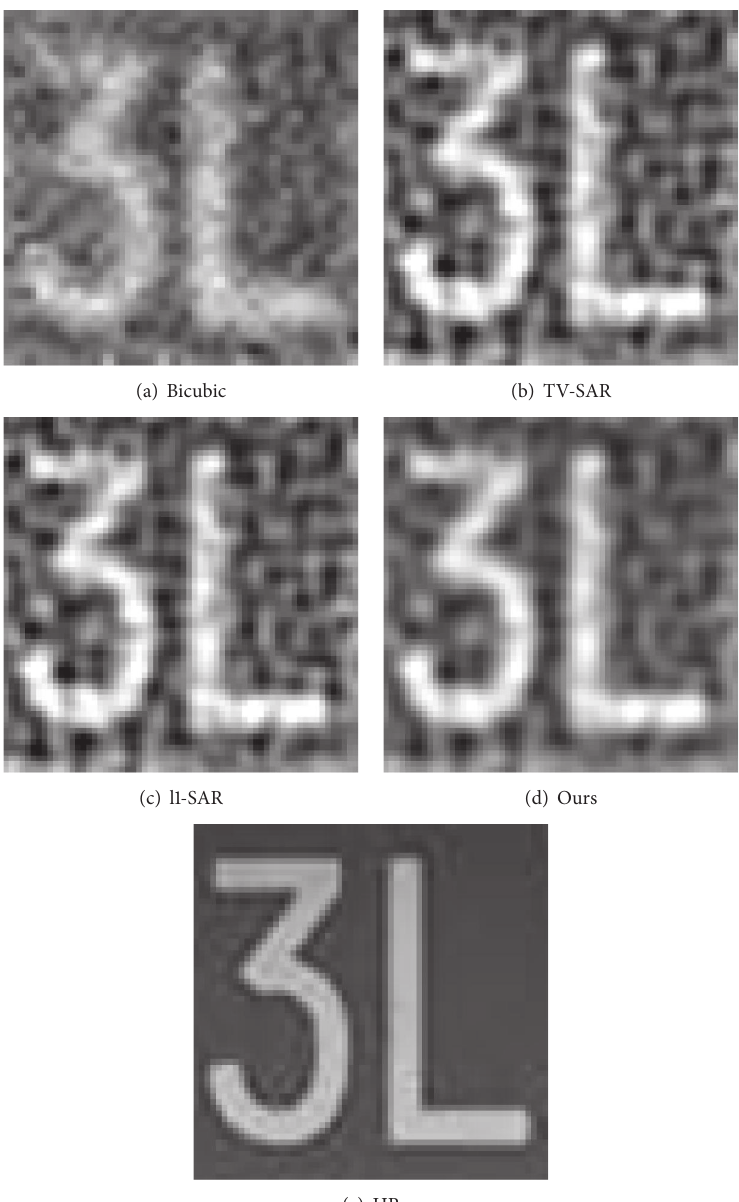
Figure 5: The reconstructed results for Figure 2(b) under white Gaussian noise with 𝜎 = 0.5 . Table 2: Comparisons of PSNR (dB) and SSIM with average blur and white Gaussian noise of 𝜎 = 0.5 . Image